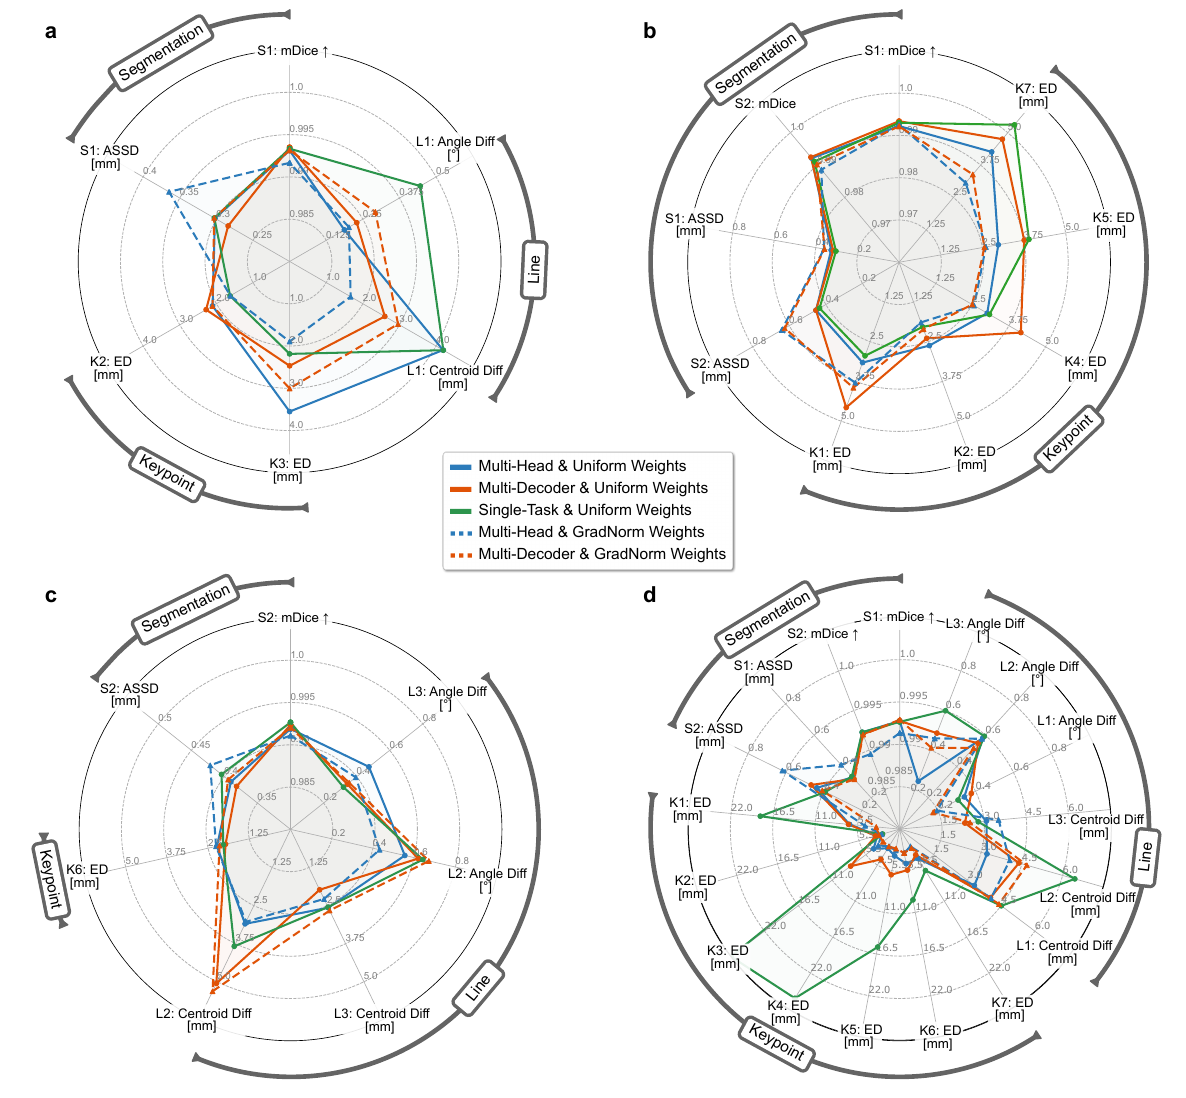
Figure 4. Radar charts of prediction errors per application and anatomical feature according to Stage A) (Section 3.1.2) and different model topologies and optimization policies. For all metrics but the mean Dice coefficient (mDice ↑ ) for segmentation tasks, lower is better. ( a ), MPFL. ( b ), ACL. ( c ), PCL. ( d ), combined (MPFL, ACL, PCL). Table 2. Analysis of the maximum intensity of keypoint heatmaps for different model topologies and task weighting strategies. Each variant’s values for mean and standard deviation ( mean ± std ) are calculated across all application-specific keypoints on every test set image. The results of the best network variant for each planning methodology is marked in